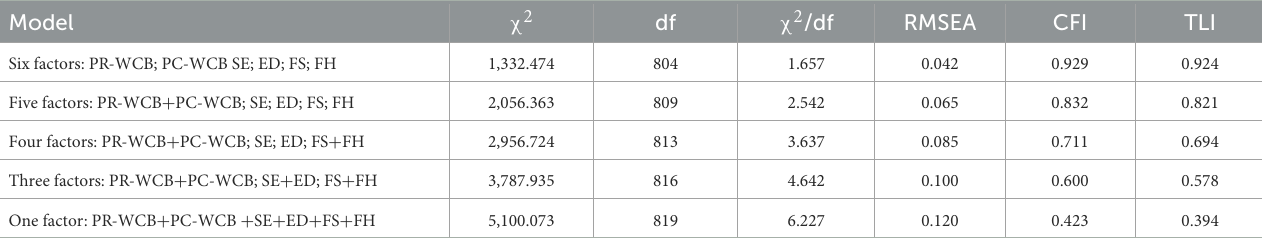
TABLE 2 Results for confirmatory factor analysis.